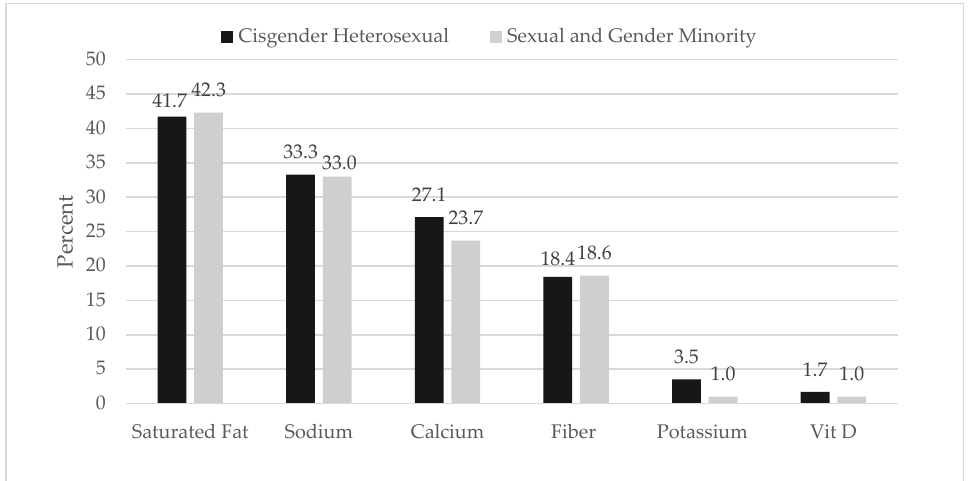
Figure 1. Percent of students that met nutrient recommendations by sexual orientation and gender identity.